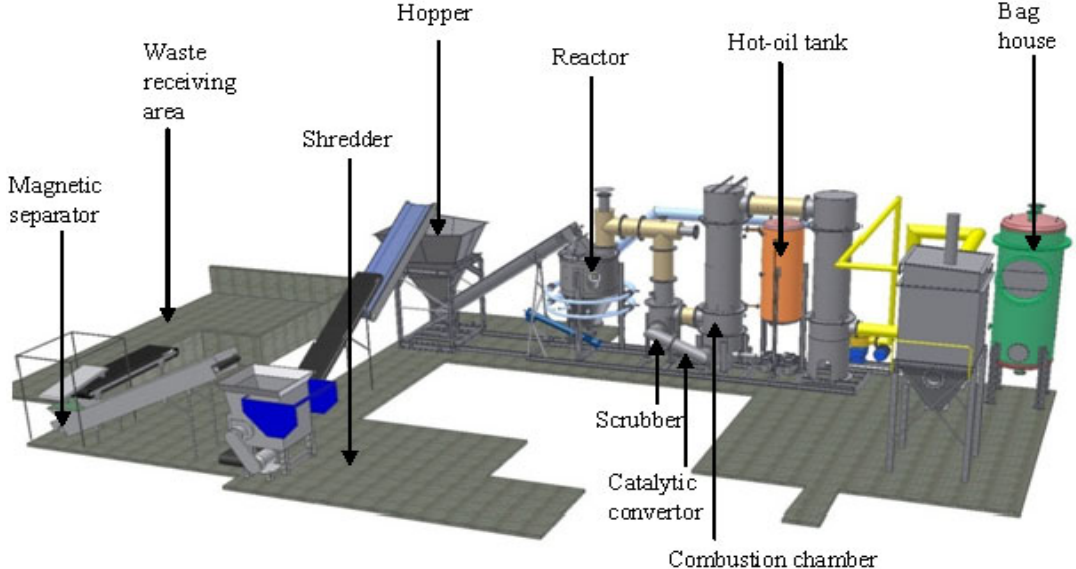
Figure 1. Layout of gasification plant (Reprinted with permission from The Corky Group, 2010